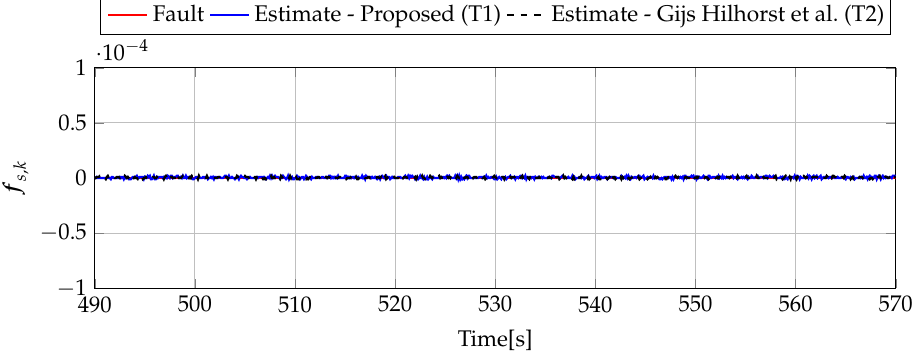
Figure 14. Sensor fault estimate for fault-free case (for t = 490, . . . ,570) with Theorem 1 (T1) and Theorem 2 (T2) based on [39] for disturbance signal w 1, k